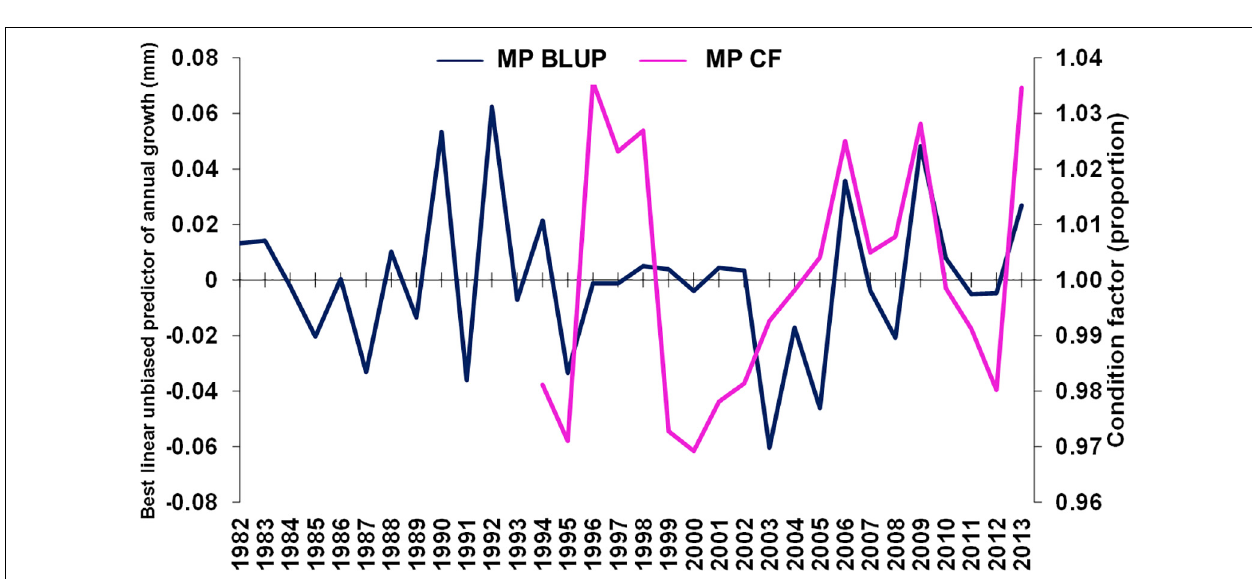
FIGURE 6 | Merluccius paradoxus (MP) caught in Namibia predicted annual growth from otolith increments (blue) and GLMM condition factor (CF, pink) against